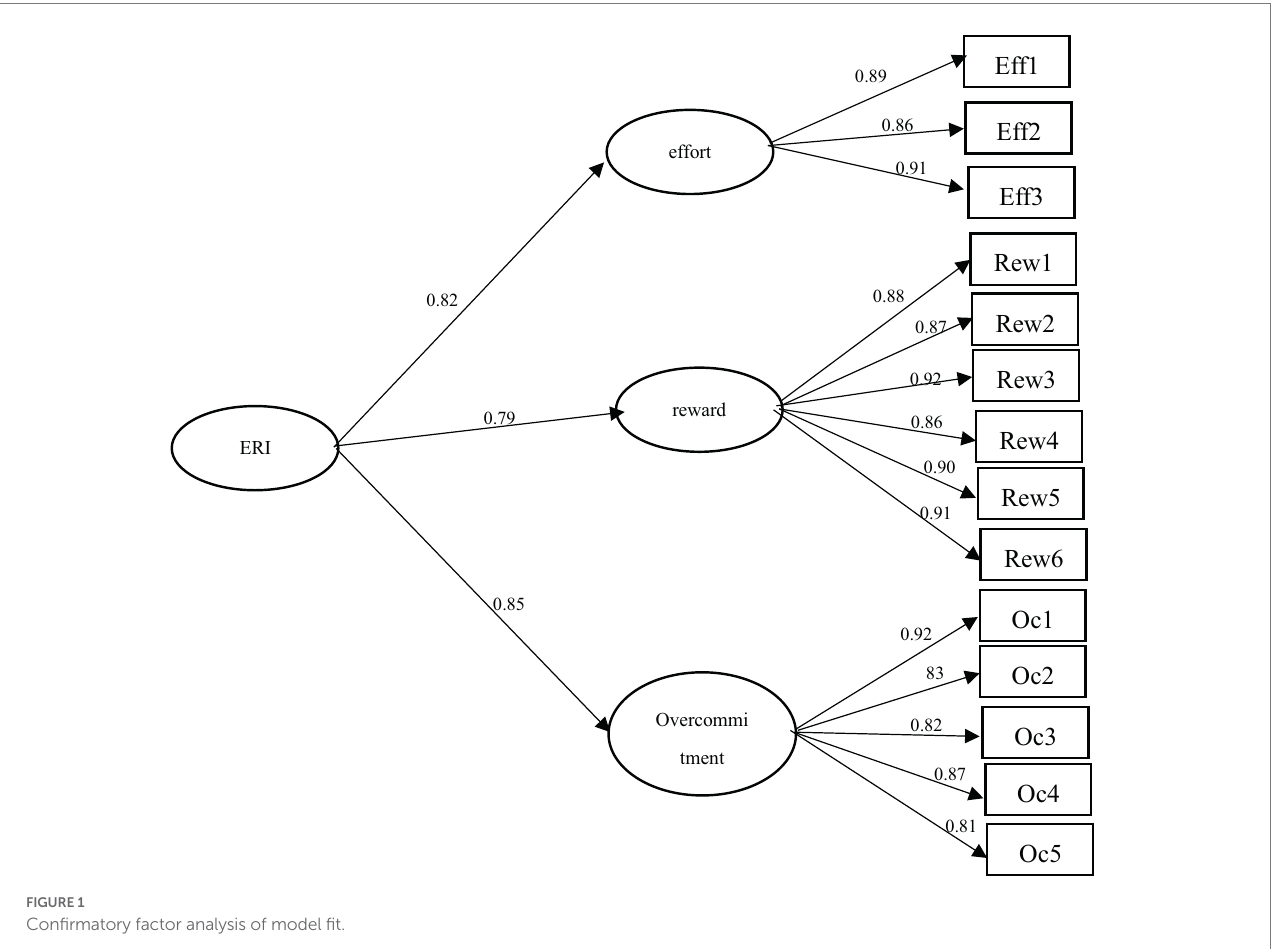
FIGURE 1 Confirmatory factor analysis of model